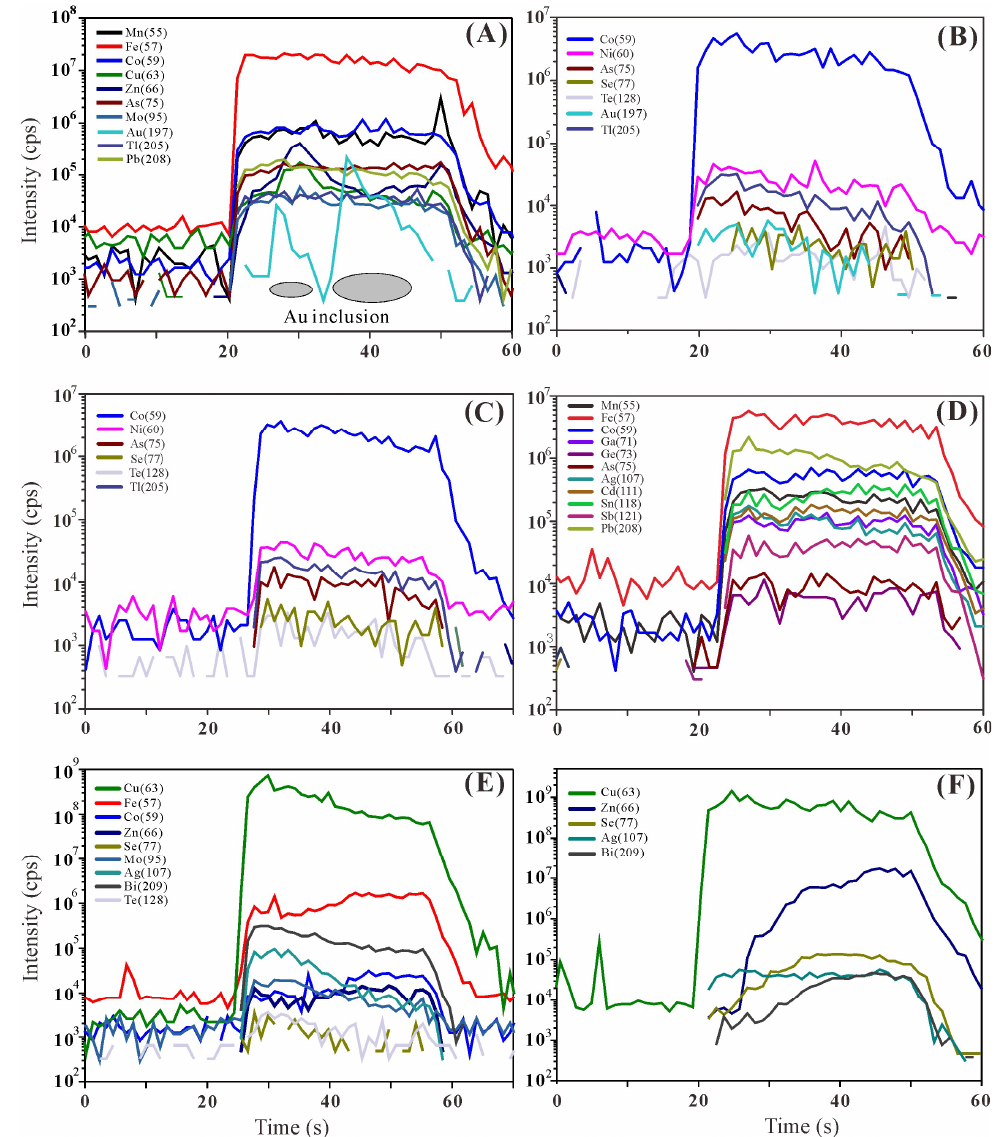
Figure 3. Representative time-resolved LA-ICP-MS depth profiles of selected elements in sulfide minerals from the Kairei vent field. ( A ) subhedral pyrite in Zn-rich chimney sulfides with inclusions of native gold; ( B ) chalcopyrite in the Cu-rich massive sulfide samples shows a homogeneous distribution of Ni, As, and Tl; ( C ) chalcopyrite showing a homogeneous distribution of Co, As, Mo, and Pb; ( D ) sphalerite with co-varying amounts of Fe and Co, Ag, Ga, Sn, and Mn; ( E ) early bornite with homogeneous Bi, Co, Mo, Ag, and Te distribution indicated by the flat signal intensities; ( F ) early bornite with elevated Zn, Bi, and Se.